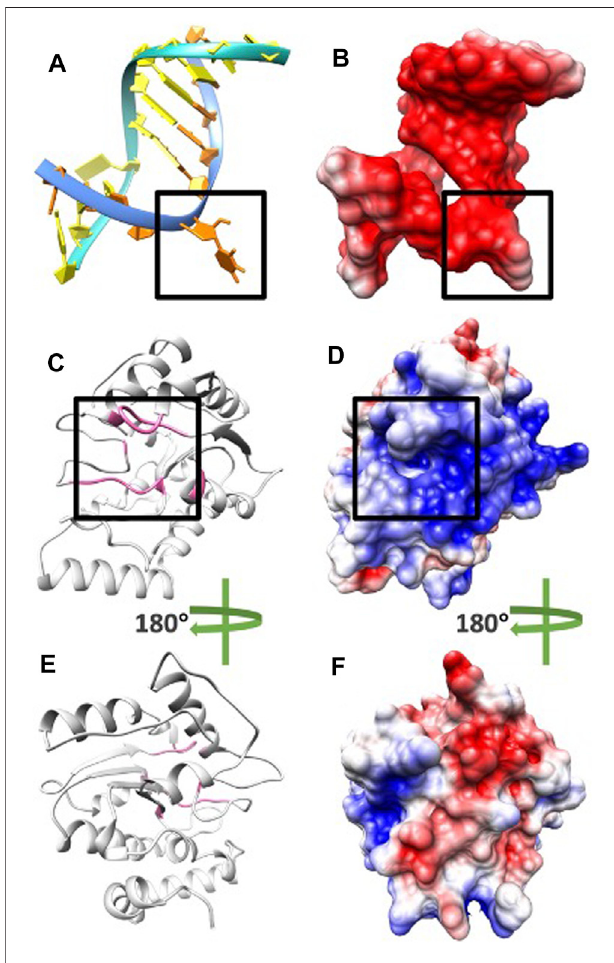
FIGURE 4 | Electrostatic potential on surfaces of DNA and UDG. (A) DNA structure orange base at location B5 fl ips out to the pocket due to UDG mechanism. (B) The electrostatic potential on the surface of DNA. (C) UDG enzyme structure (pocket side) and the residues of the binding pocket are colored in pink. (D) The electrostatic potential on the surface of UDG front side and the black squareis the pocket area. (E) UDG enzyme structure (non- pocketside)andtheresiduesofthebindingpocketarecoloredinpink. (F) The electrostatic potential on the surface of UDG non-pocket side. In fi gures BDF, the negatively and positively charged areas are colored in red and blue,